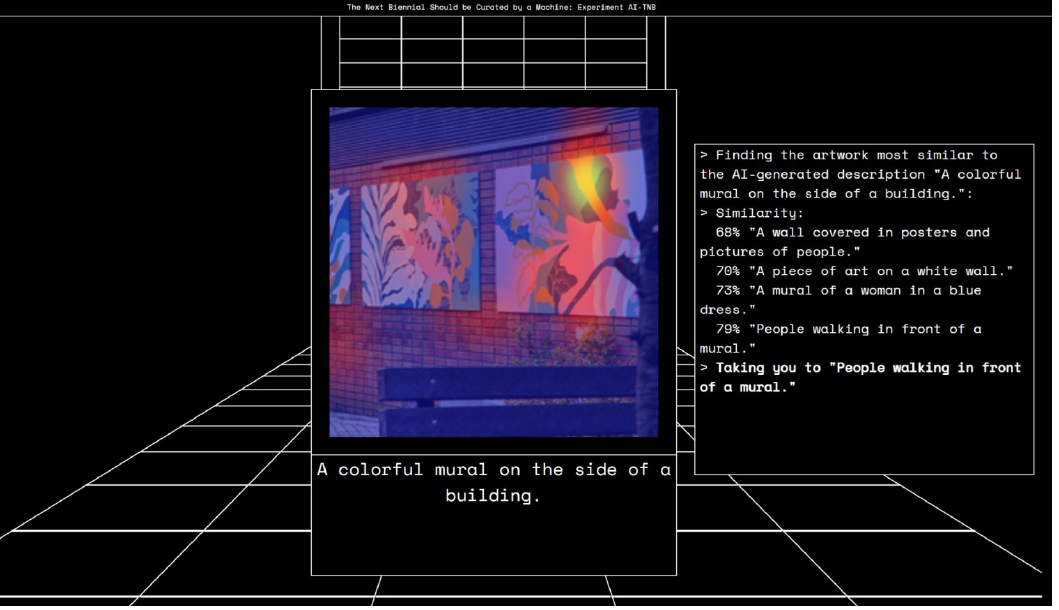
Figure 16. Ranking of most similar artworks on the basis of their AI-generated descriptions. Joasia Krysa, Leonardo Impett and Eva Cetinic. The Next Biennial Should Be Curated by a Machine. Experiment: AI-TNB. Available online: https://metaobjects.org/testing/liverpoolbiennial/ (accessed on 18 July 2022) (screenshot).